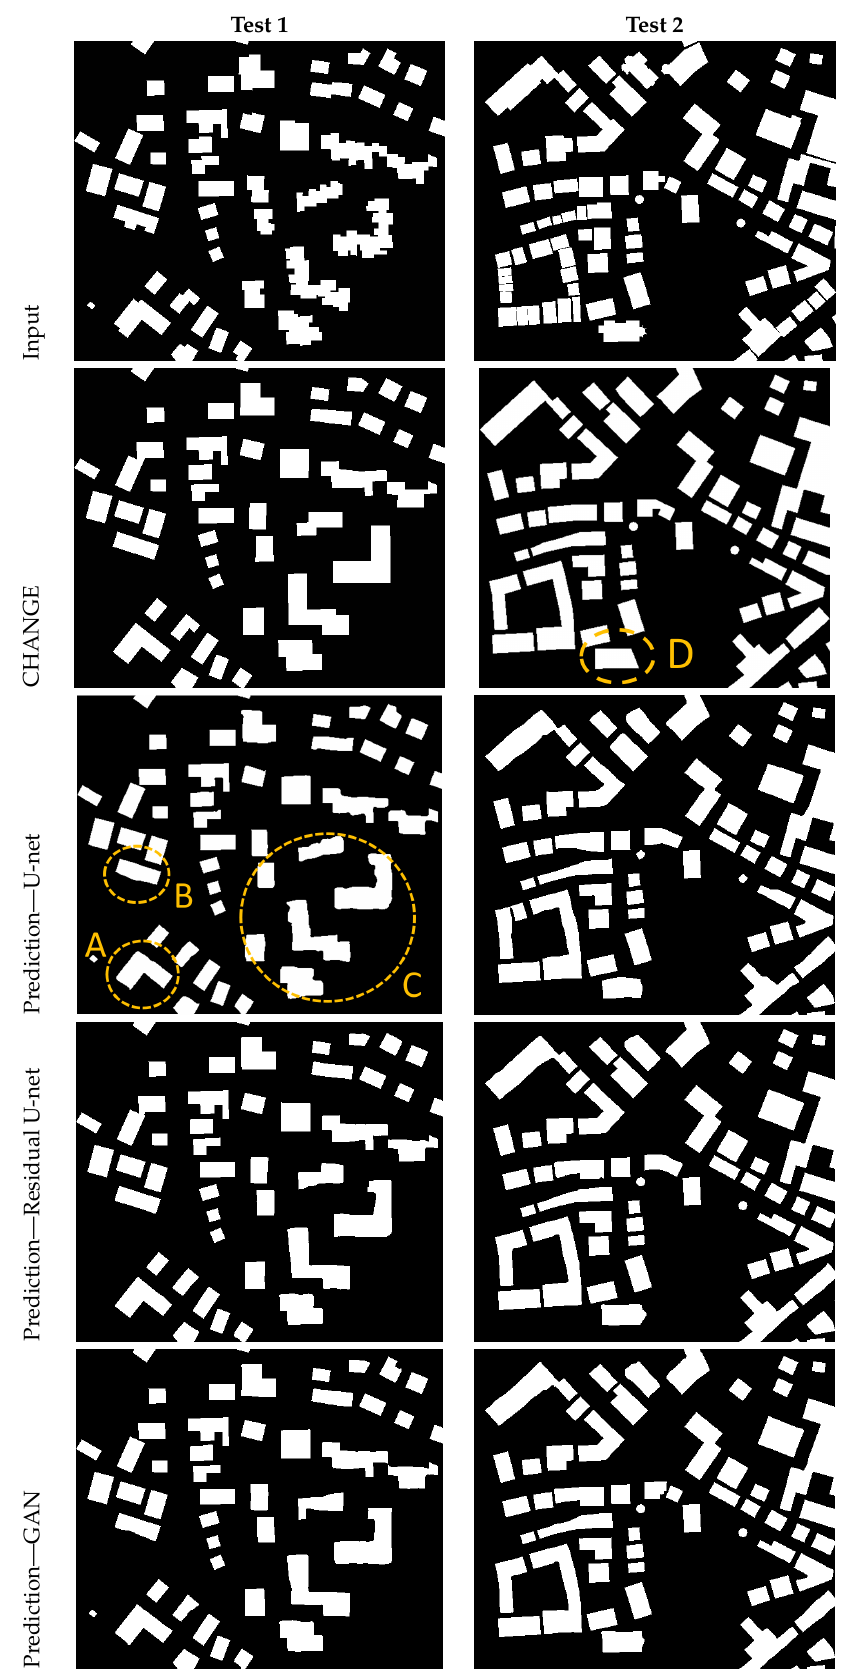
Figure 10. Evaluation of different models on independent test at map scale